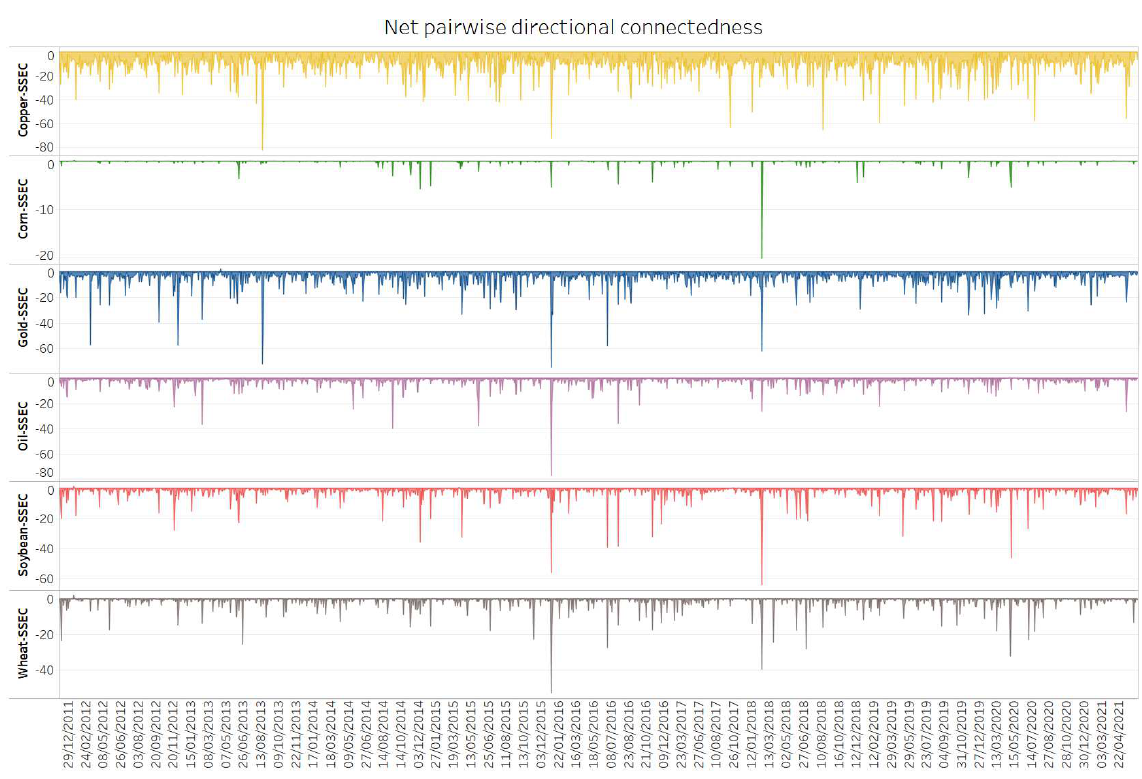
Figure 4. Net pairwise directional